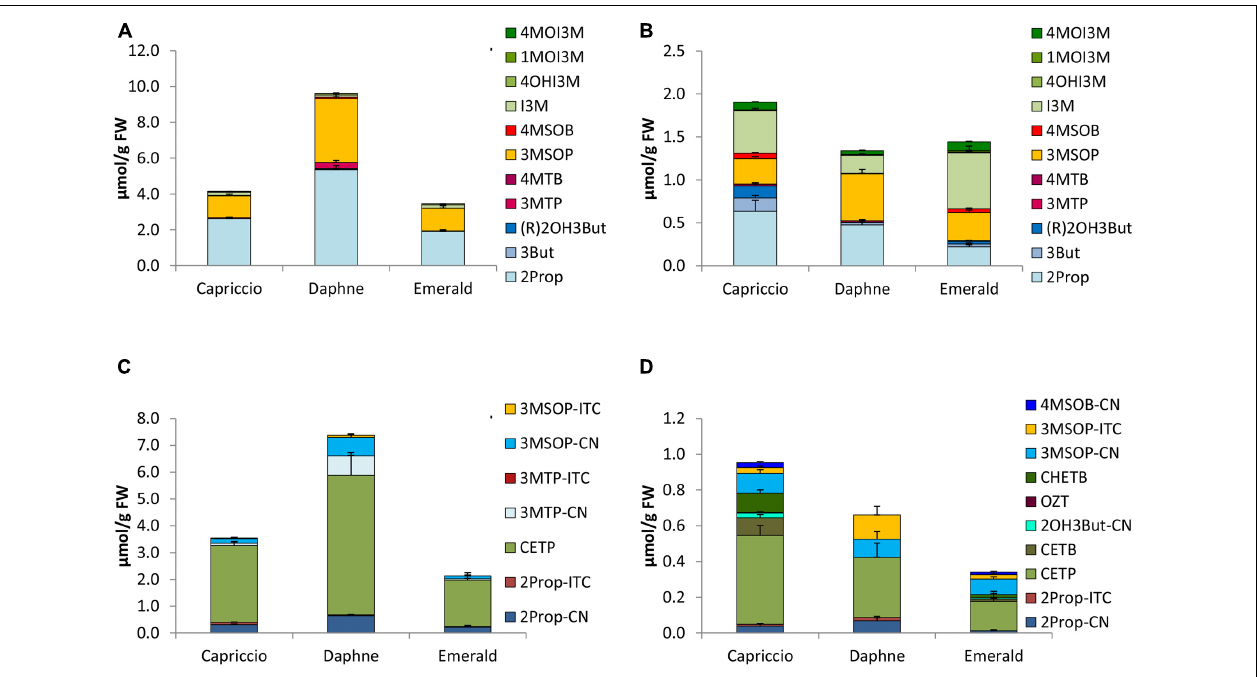
FIGURE 6 | Glucosinolates [ µ mol/g FW] and their hydrolysis products [ µ mol/g FW] in different cultivars of savoy cabbage in sprouts [ (A) GLS, (C) hydrolysis products] and fully developed savoy cabbage heads [ (B) GLSs, (D) hydrolysis products]. Abbreviations: see Table 2